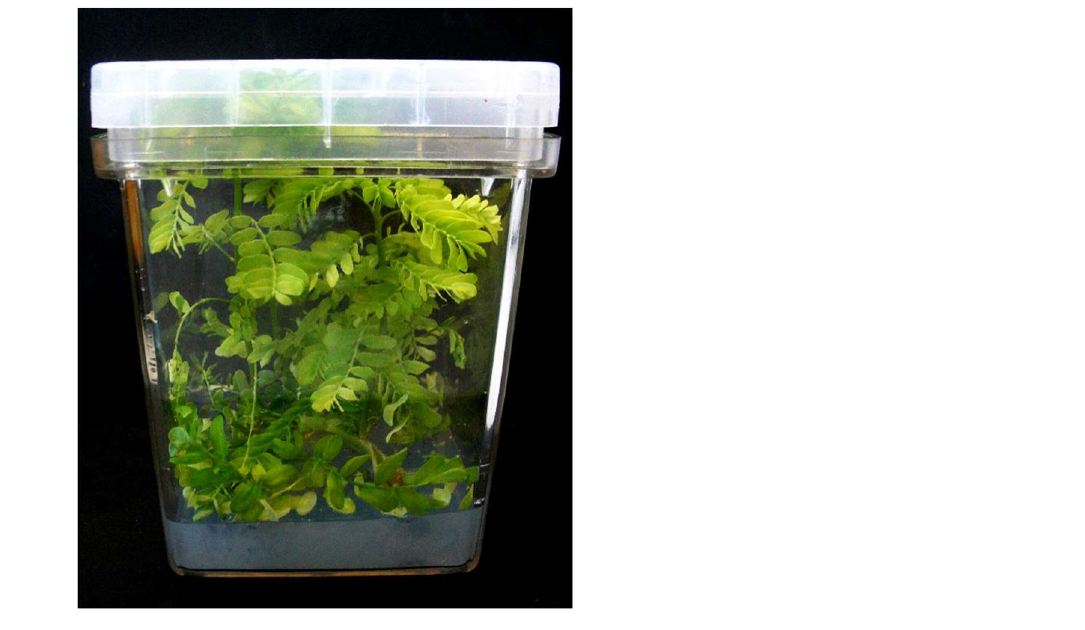
Figure 2. Shoot culture of P. amarus (MS 0